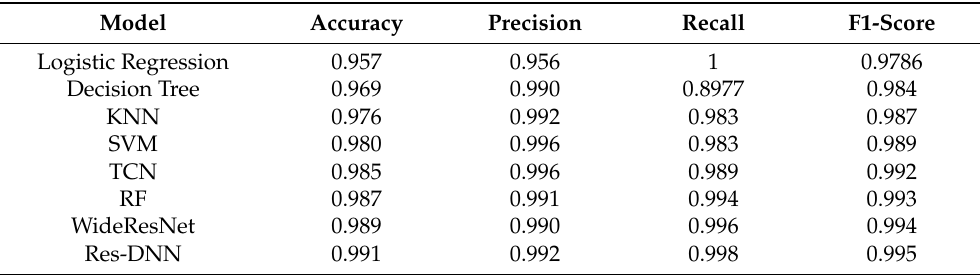
Table 4. Performance of the classifiers in distinguishing between the known and unknown vendors.